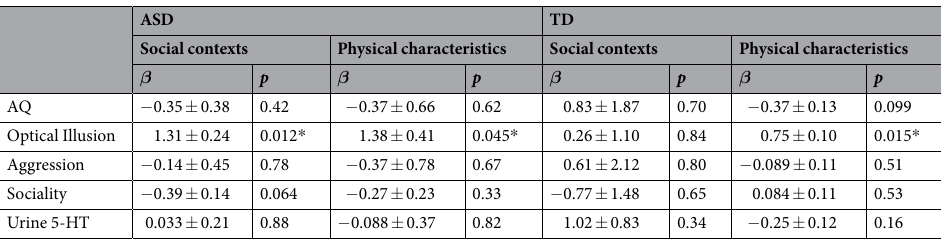
Table 2. Multiple regression analysis for associations between social rank recognition and several factors of interest. Mean ± s.e.m.; * Statistical